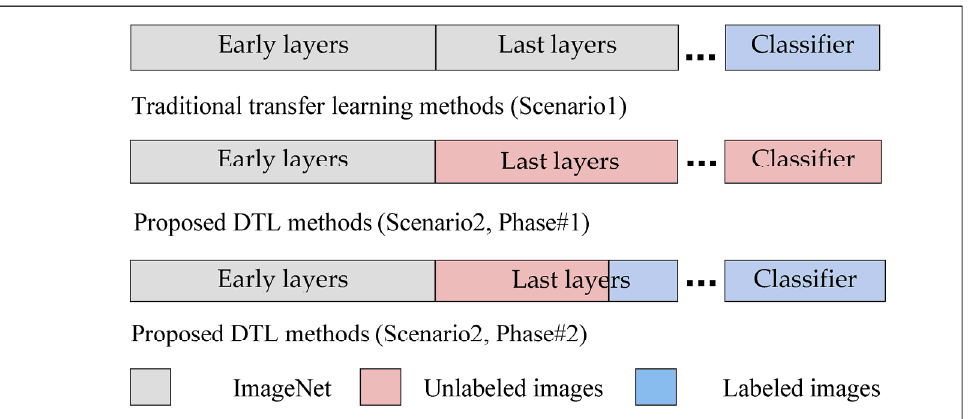
Figure 2. The difference between traditional transfer learning and proposed DTL methods.